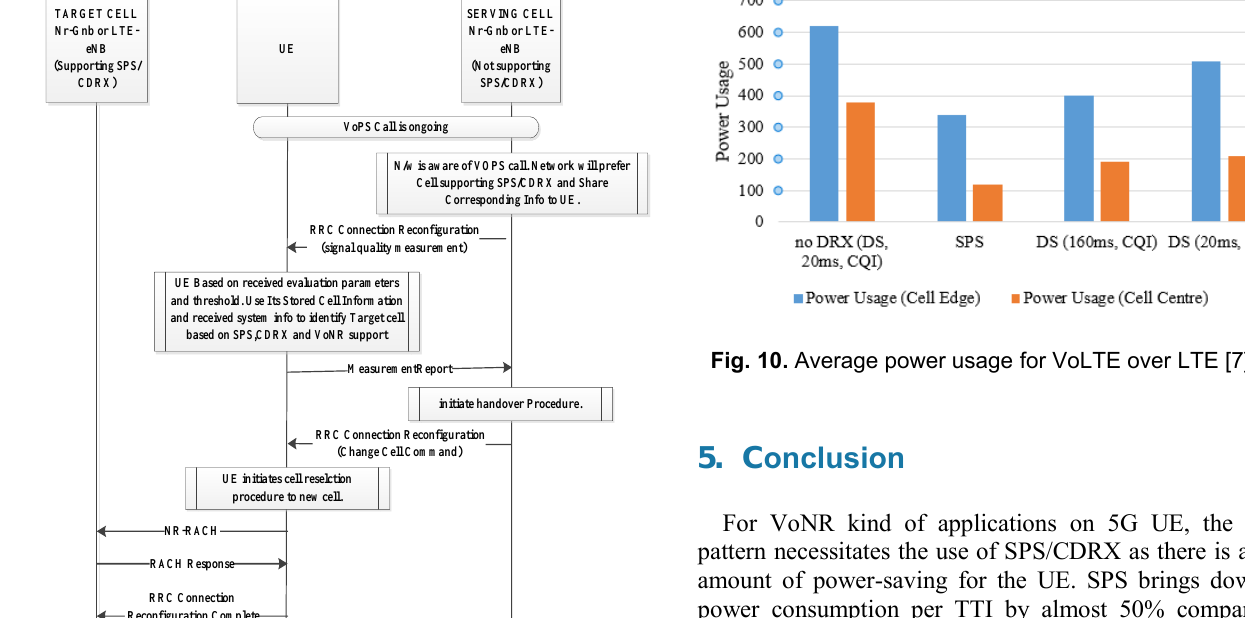
For VoNR kind of applications on 5G UE, the traffic pattern necessitates the use of SPS/CDRX as there is a good amount of power-saving for the UE. SPS brings down the power consumption per TTI by almost 50% compared to dynamic scheduling and further 10-15% if we use Connected DRX in the deployment. SPS and CDRX are gNB scheduler implementation and depend on UE support (capability information). In our proposed solution, we discuss a method to assist UE in the early detection of SPS/CDRX in the gNB scheduler through an internal database in UE. Through our proposed changes, the 5G UEs conserve more energy when the user activates the VoNR